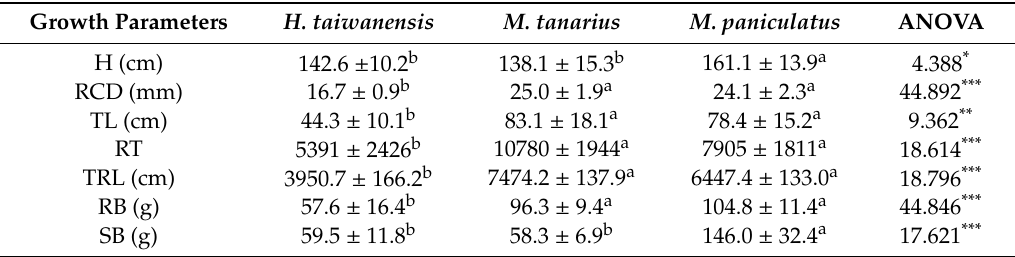
Table 3. Means ± standard deviations of growth performance for the three species studied and F-values for one-way ANOVA.